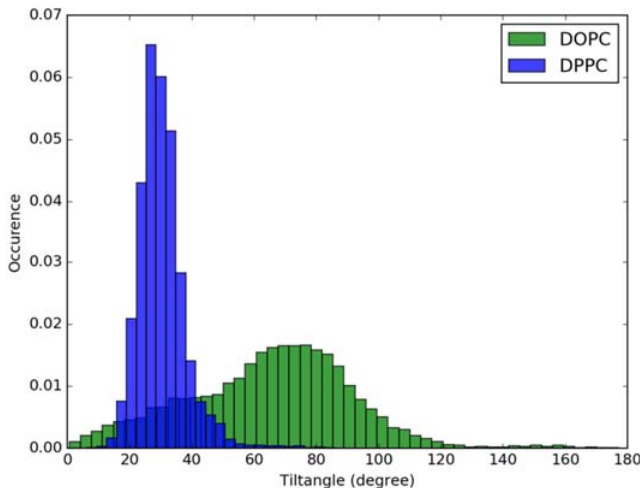
Figure 4. Histogram of tilt angle of Laurdan fluorophore in the ground state incorporated into lipid bilayers.